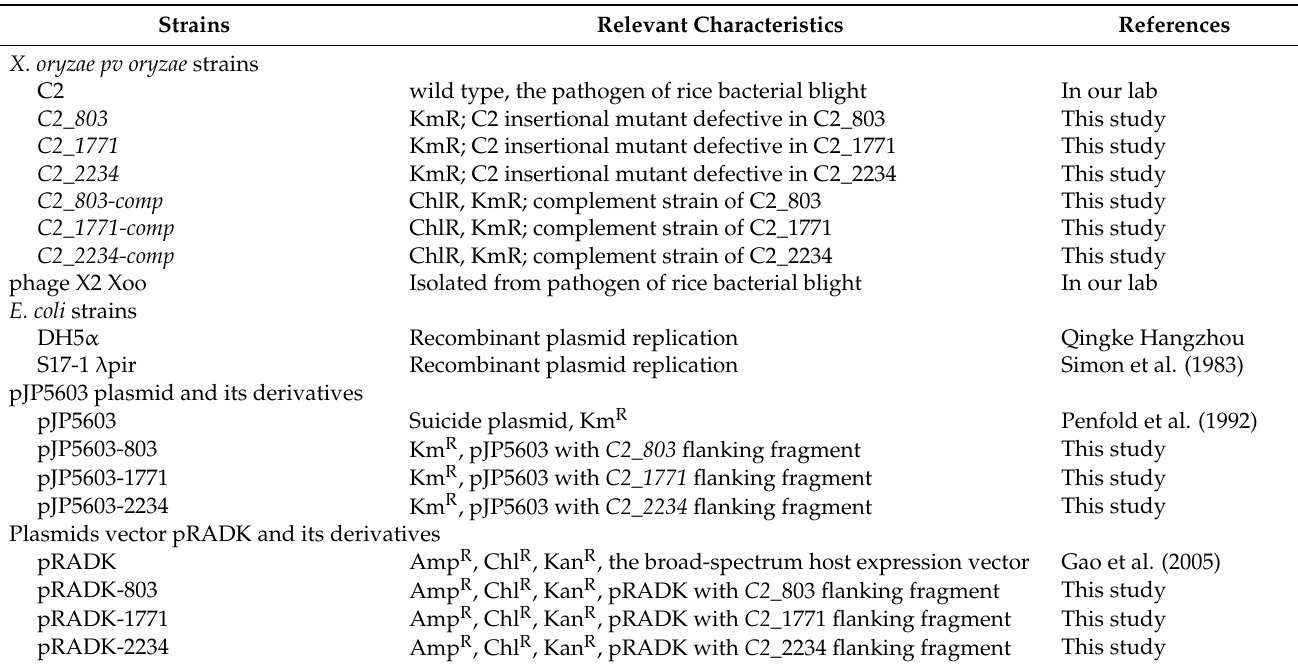
Table 2. List of plasmids and bacterial strains used in this